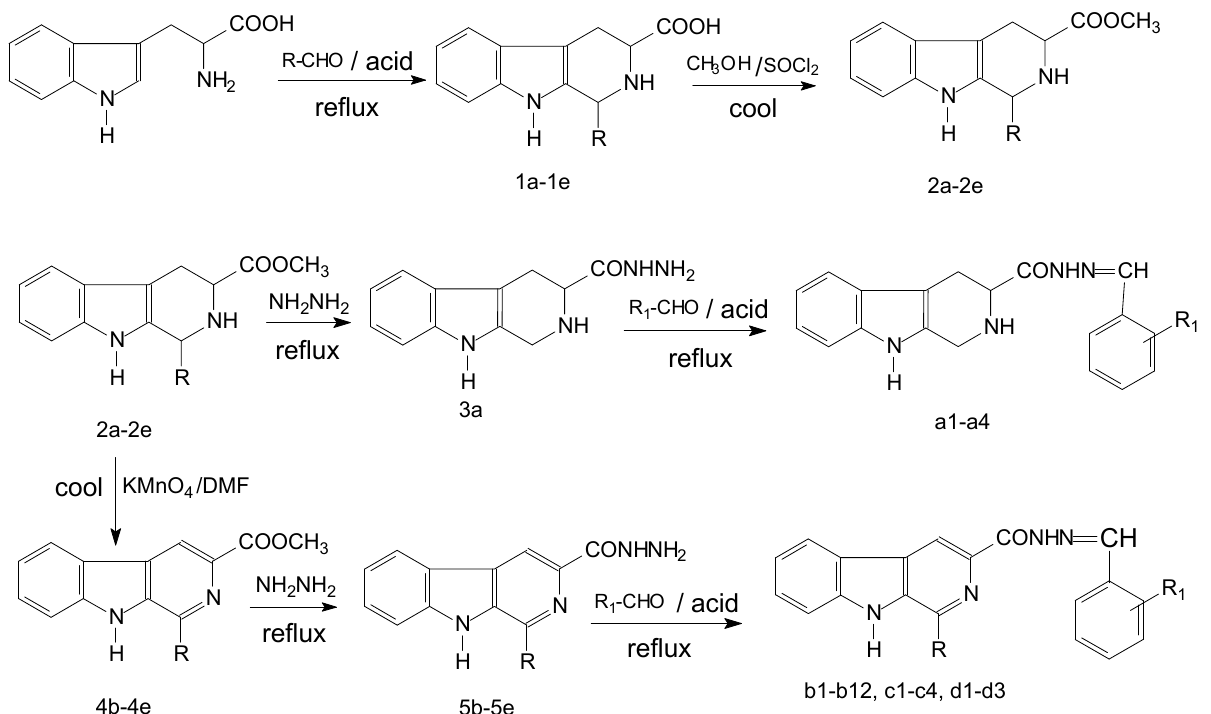
Scheme 1. The synthetic protocols for the target compounds.